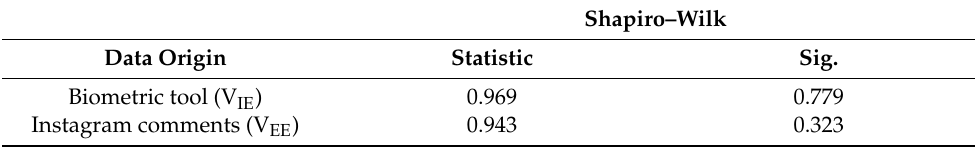
Table 4. Result for normality test.